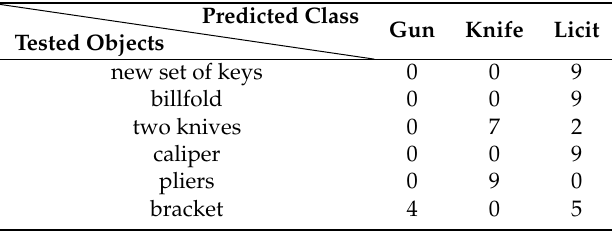
Table 13. Confusion matrix for additional objects; cross-validation and test phase; 9 images among which 8 obtained by bootstrap. Predicted Class Gun Knife Licit Tested Objects new set of keys 0 0 9 billfold 0